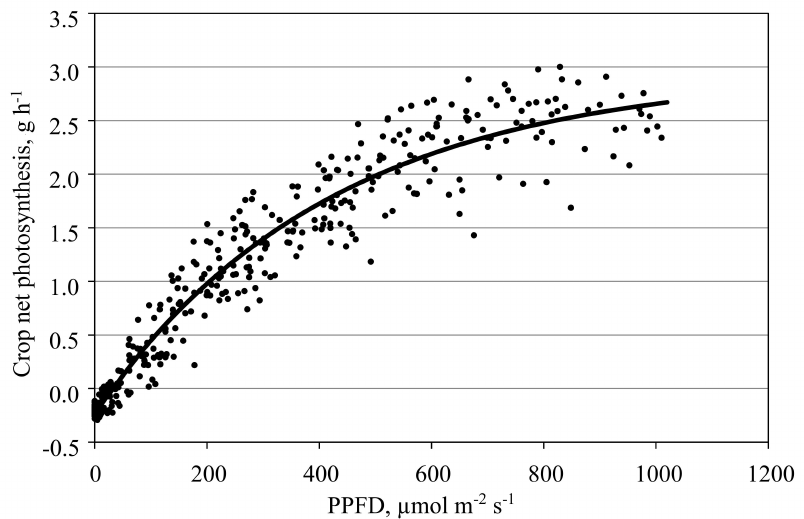
Figure 7. Net photosynthesis of a tomato crop measured in the closed chamber mode a ff ected by PPFD. Data shows hourly averages of measurements smoothed over three hours in one cabin in the period from 01 April to 02 May 2016. Leaf area index increased during this period from 1.4 to 2.0 m 2 m − 2 . CO 2 concentration ranged between 500 µ mol mol − 1 at night and 330 µ mol mol − 1 during the day. The line depicts the negative exponential PPFD response curve fitted with the